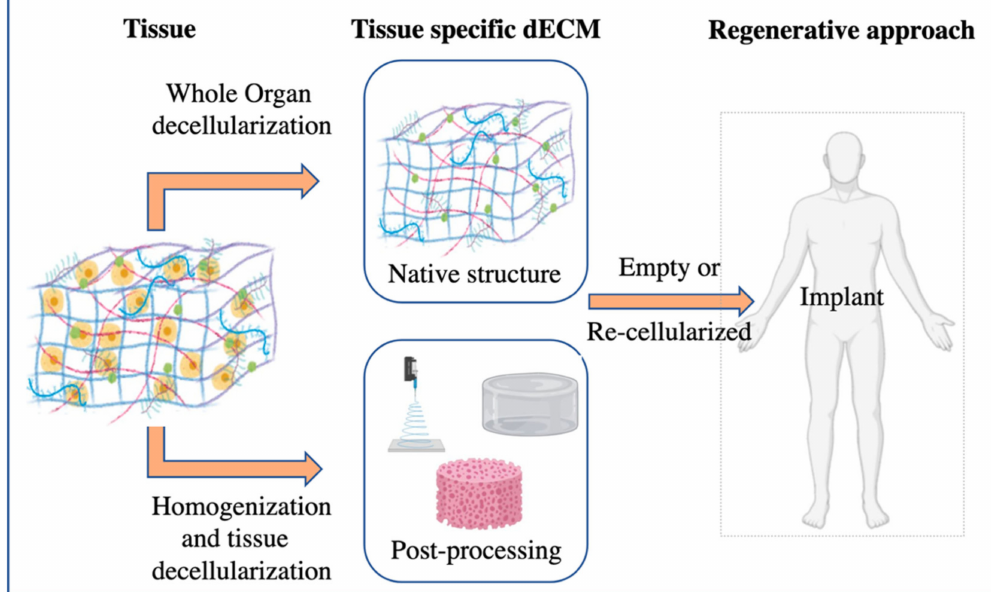
Figure 3. Schematic of organ decellularization and tissue decellularization